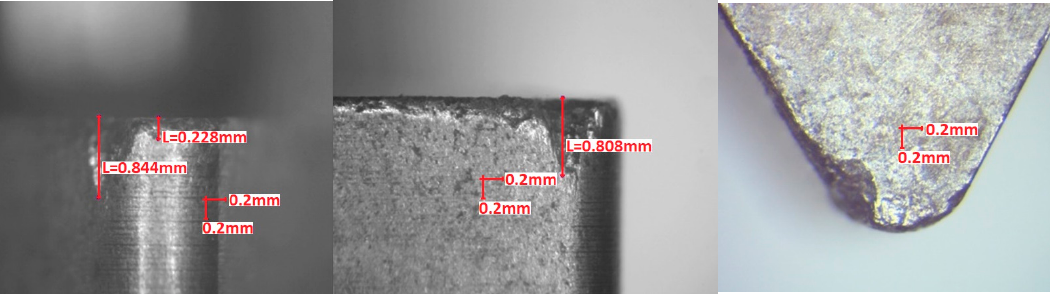
Figure 10. Rhenium implanted at dose 2 × 10 17 ion/cm 2 TNGA 160408E (IS9) edge after turning test ( VB N = 0.8 mm, VB C = 0.2 mm).